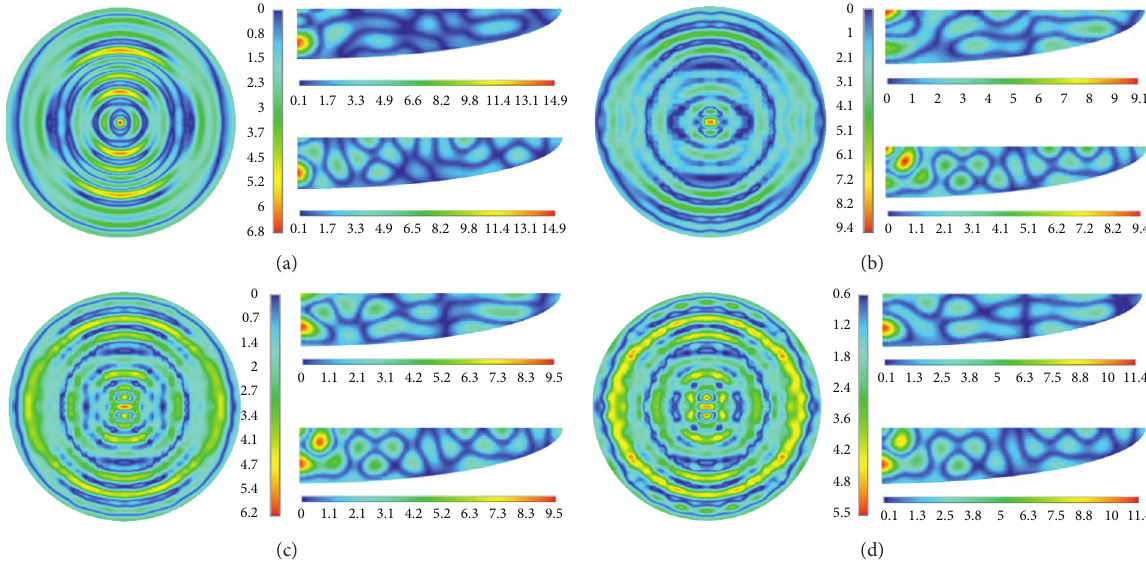
Figure 15: The displacement amplitude of the homogeneous sedimentary basin ( f � 3.0Hz): (a) no buildings; (b) D � 55m; (c) D � 62.5m; (d) D � 70